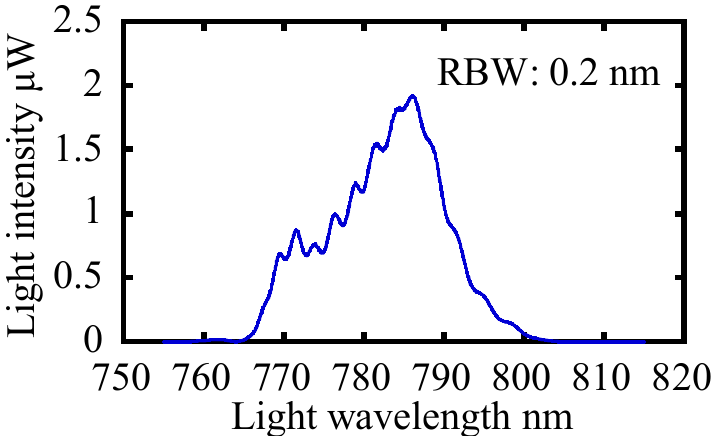
Figure 9. The optical spectrum of the mode-locked femtosecond laser employed in this paper. Meanwhile, the detector unit had a small angular misalignment β about the X -axis even after the alignment; this can be evaluated in experiments by using the positive and negative first-order diffracted beams. Figure 10a,b show the variations of the spectra of the positive and negative first-order diffracted beams captured by the same detector unit when rotating the scale grating. In the figures, the spectra obtained at the angular position | θ | ranging from 27.48 ◦ to 27.52 ◦ in a step of 0.01 ◦ are plotted. As can be seen in the figure, the spectra of the negative first-order diffracted beams were found to